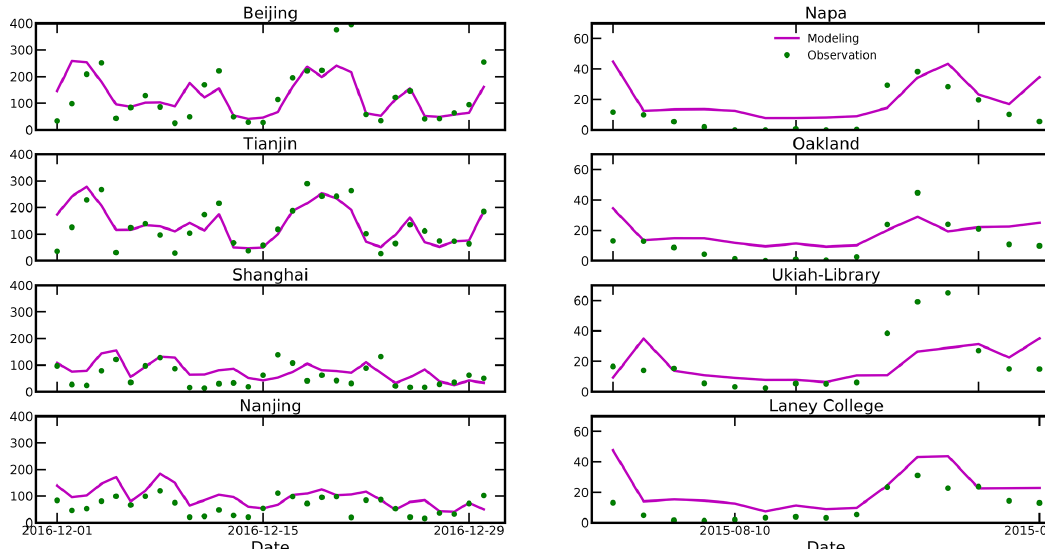
Figure 2. Comparison of measured and calculated PM 2 . 5 concentrations.